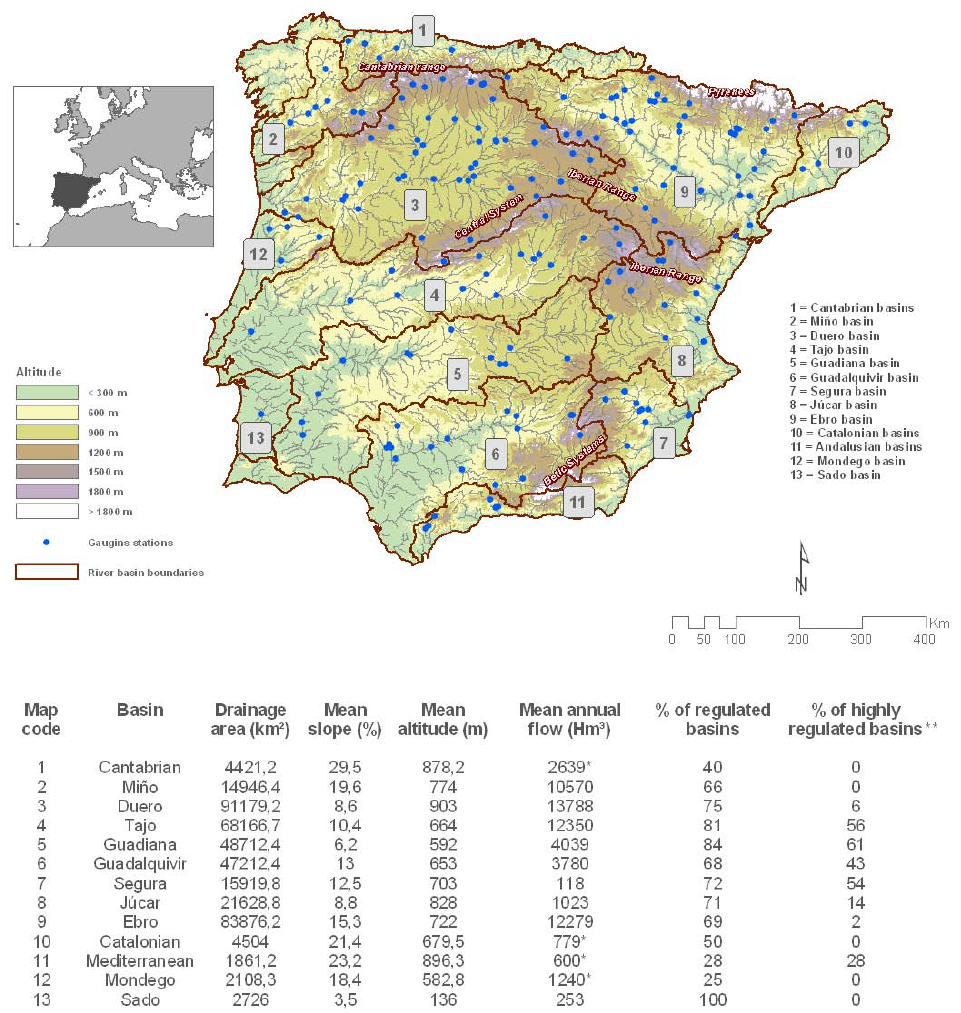
Fig. 1. Up: location of the 187 streamflow series for the period 1945–2005 used in the study. Down: Characteristics of the main river basins. Note that the streamflow is referred to the gauging station closest to the river mouth to the sea. * sum of the annual flows of all gauging stations belonging to the basin, since there are not a main course which accounts for the water yield of the whole basin. ** highly regulated basins include all basins with a mean annual discharge below its retention